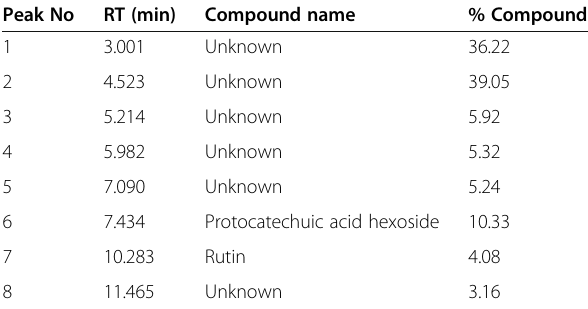
Table 5 HPLC validation data of bioactive F-D for polyphenol standards